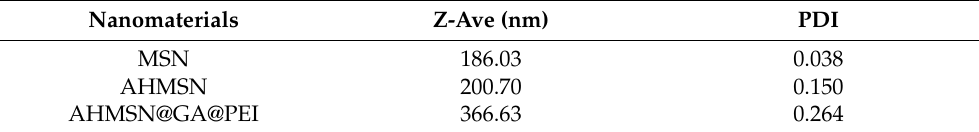
Table 1. Hydrated particle size and PDI of MSN, AHMSN and AHMSN@GA@PEI.